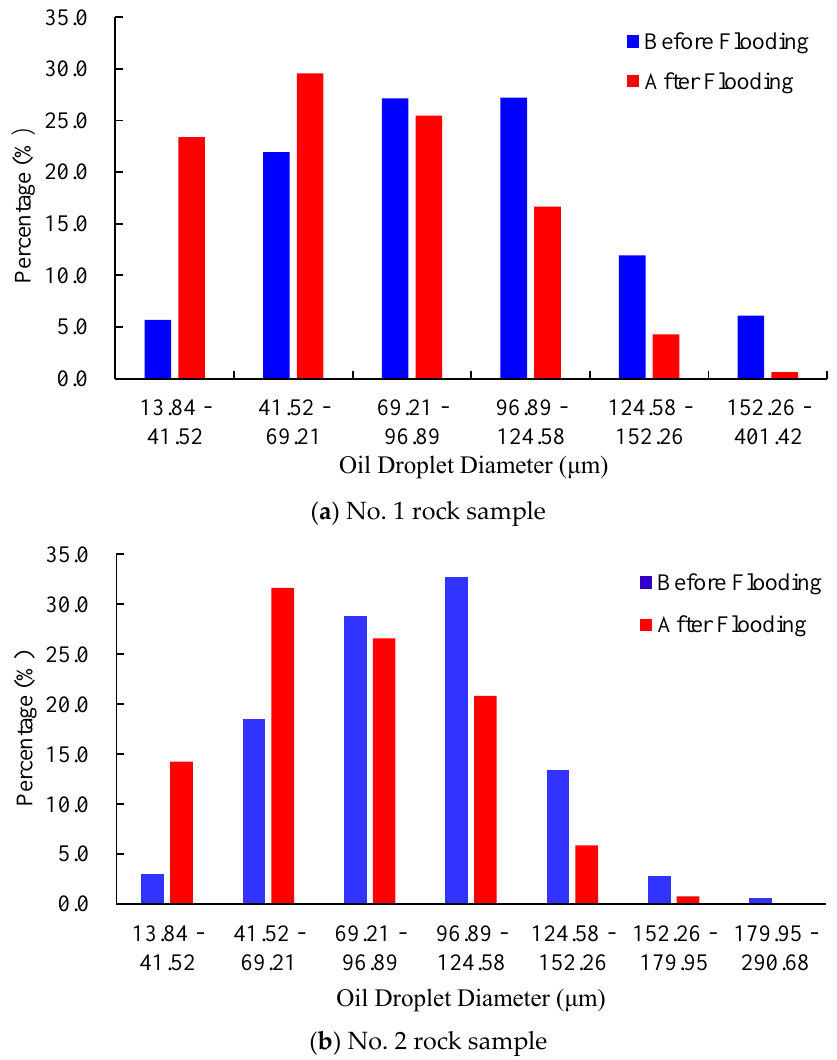
Figure 13. Frequency distribution of oil droplets’ diameter during P-S flooding. Table 3. Average geometric properties of oil droplets during P-S